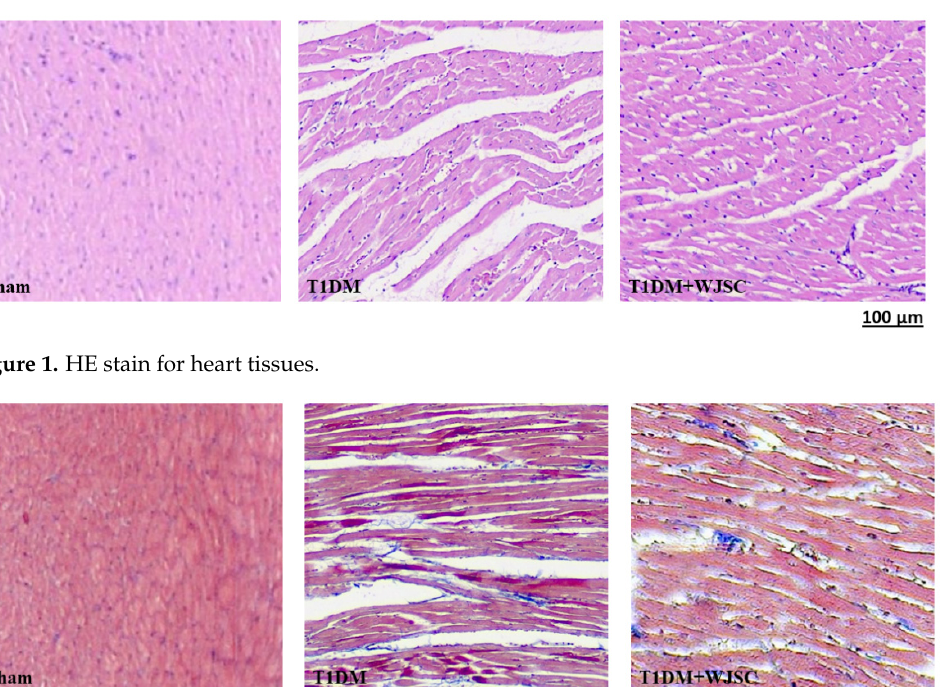
Figure 2. Masson’s Trichrome stain for heart tissues.